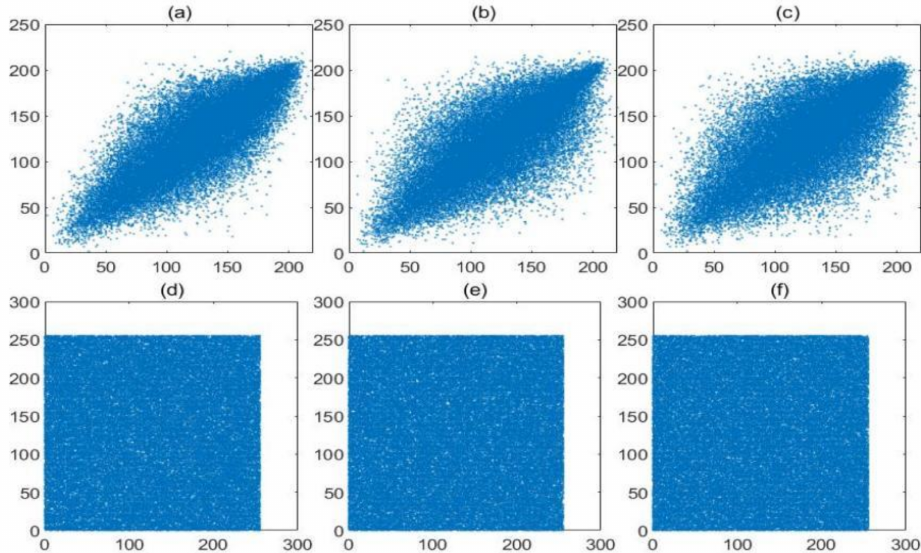
Figure 15. Correlation analysis of Baboon image: ( a ) Adjacent pixel points of the plain-text image in horizontal direction; ( b ) Adjacent pixel points of the plain-text image in vertical direction; ( c ) Adjacent pixel points of the plain-text image in diagonal direction; ( d ) Adjacent pixel points of the encrypted image in horizontal direction; ( e ) Adjacent pixel points of the encrypted image in vertical direction; ( f ) Adjacent pixel points of the encrypted image in diagonal direction.